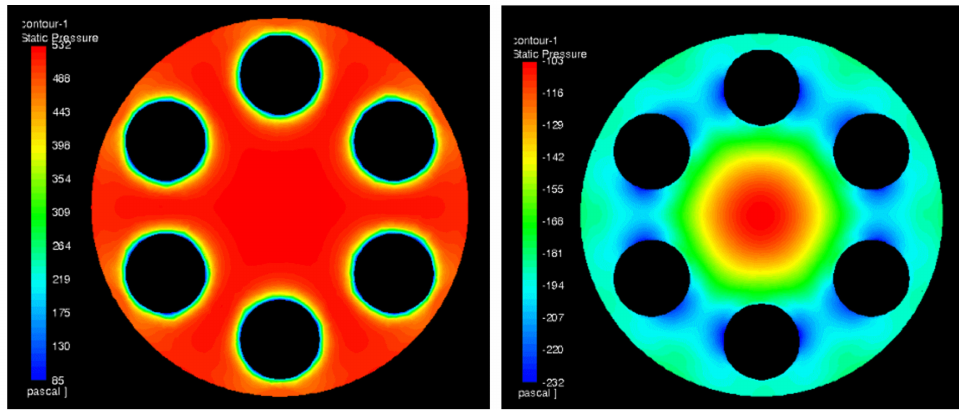
Figure 23. Pressure drop distribution for the case without the obstacle on the upstream ( left ) and downstream ( right ) side of the orifice.